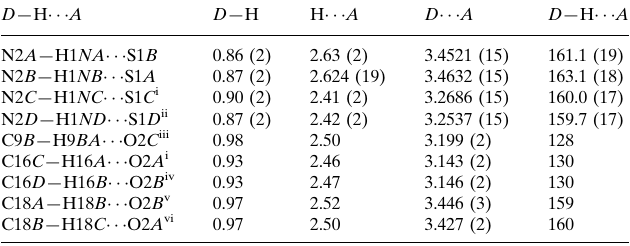
Hydrogen-bond geometry (A˚ , (cid:2)